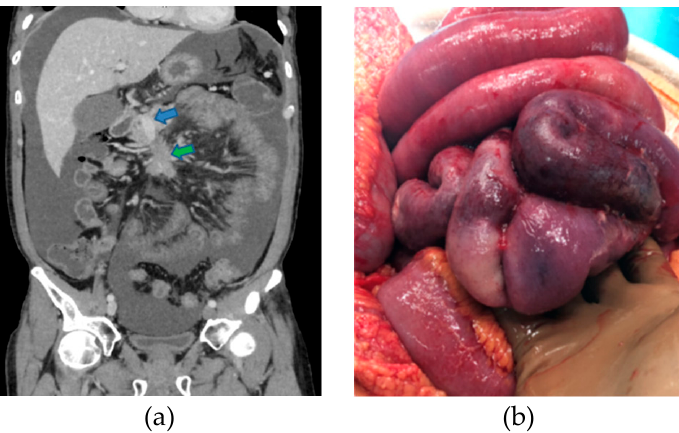
Figure 5. Mesenteric ischemia due to bulky MLNM with encasement of the mesenteric vessels. ( a ) Computed tomography (CT) scan: mesenteric superior venous stenosis (blue arrow) and MLNM (green arrow). ( b ) Debulking surgery for mesenteric ischemia due to mesenteric vessels encasement by MLNM.